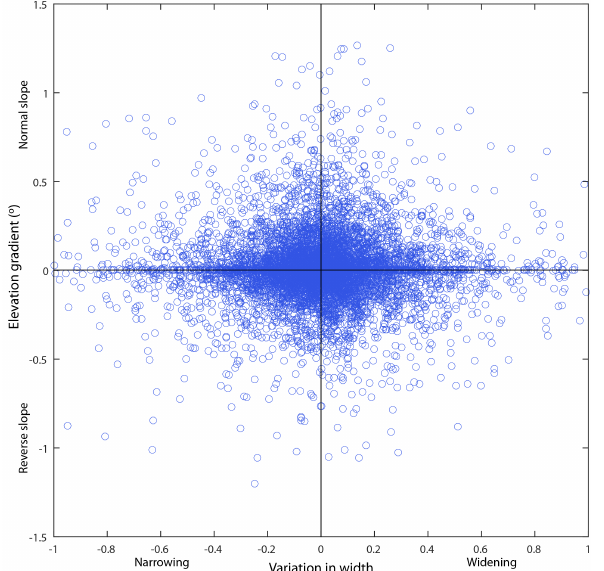
Figure 10. Scatter plot compiled to investigate if downstream vari- ation in channel width was controlled by variations in downstream slope gradient (see text for details). That the data are centred on zero and spread fairly evenly around this demonstrates that there is no systematic relationship between elevation gradient (i.e., whether it is a normal or reverse gradient slope) and width (i.e., whether the tunnel valley is narrowing or widening).